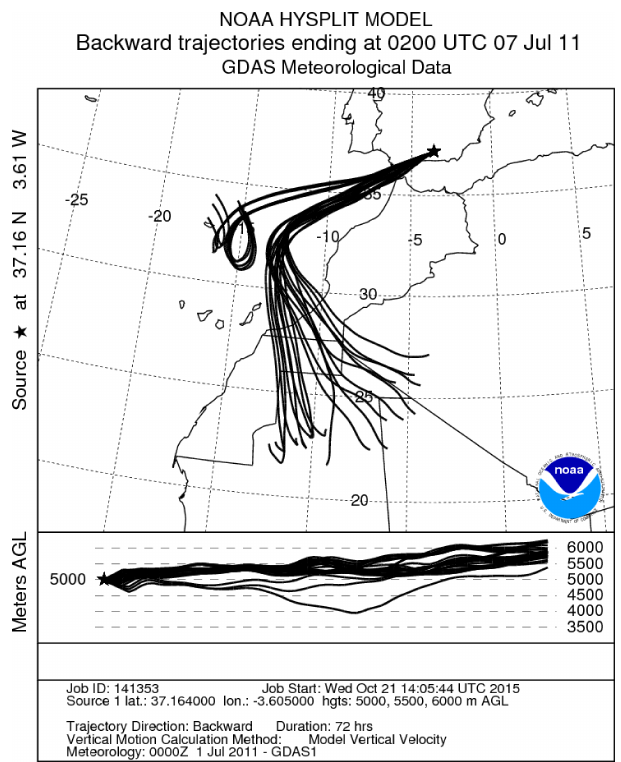
Figure 4. HYSPLIT backward trajectories for the overpass over the EARLINET station in Granada on 7 July 2011 at 02:00UTC con- firm that the air mass came from the region of northwestern Africa, over Gibraltar, and towards the southern part of Spain.